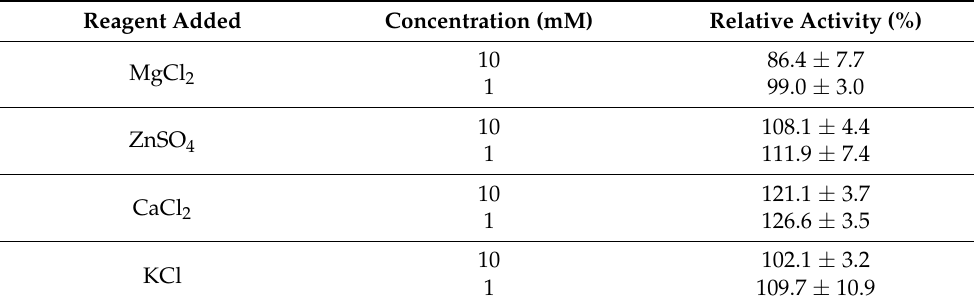
Table 5. Effect of metal ions on β gal5 activity. Data were obtained from biological replicates ( n = 3). Reagent